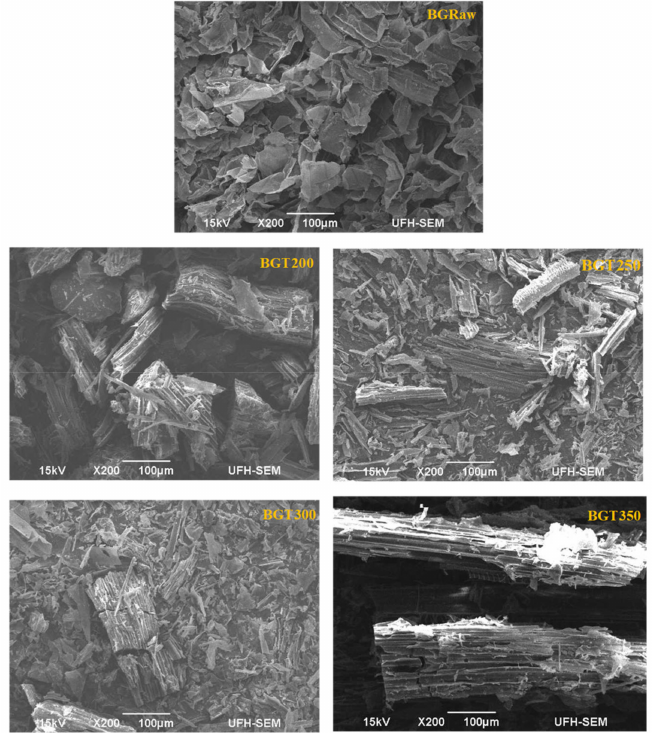
Figure 6. SEM images of raw bagasse (BGRaw) and torrefied bagasse at 200 ◦ C (BGT200), 250 ◦